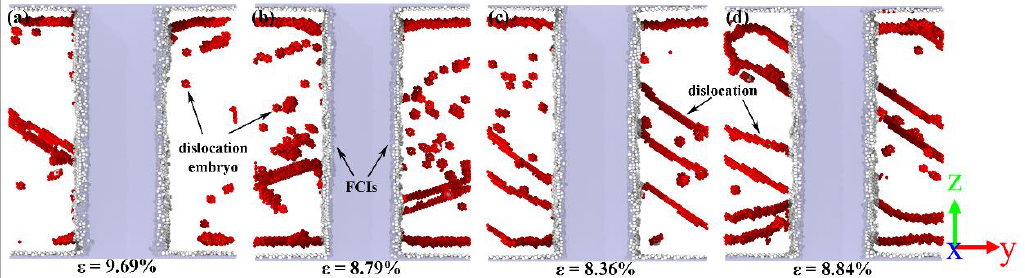
Figure 7. Atomic configurations for the dislocation nucleation of ( a ) Fe2C model, ( b ) Fe3C model, ( c ) Fe4C model, and ( d ) Fe7C3 model. The red atoms are the stacking fault atoms, and the white atoms are the disordered atoms at FCIs and boundary.